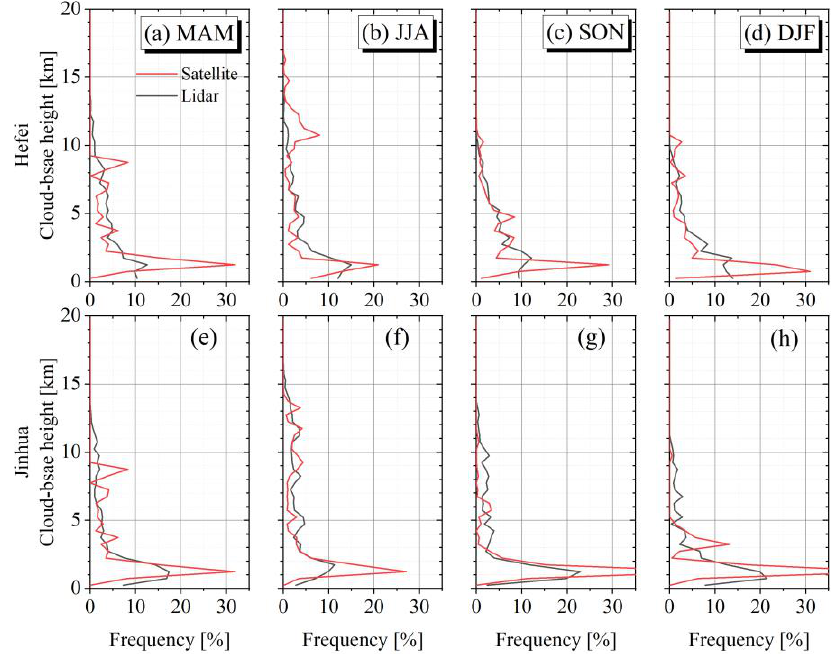
Figure 9. Seasonal occurrence frequency of cloud base height measured by CALIPSO and CloudSat or ground-based lidar. (a)-(d) represent four-season results over Hefei site. (e)-(h) represent four-season results over Jinhua site.